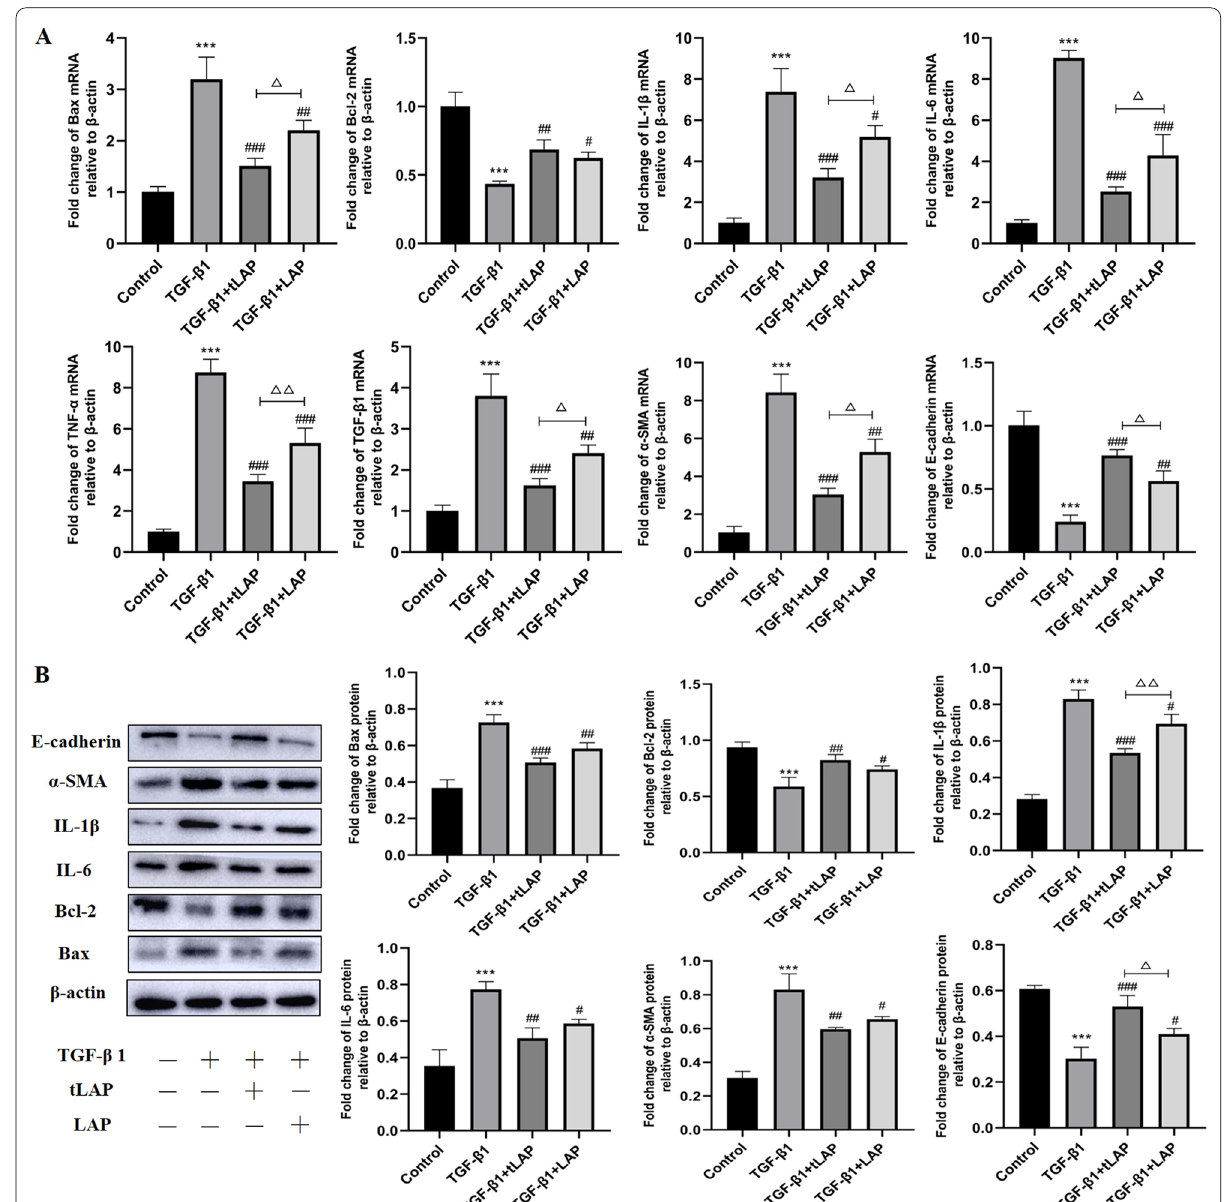
Fig. 3 Detection of the effects of LAP and tLAP on TGF-β1-induced apoptosis and EMT in AML12 cells. A Detection of the mRNA expression of Bax, Bcl-2, IL-6, IL-1β, TNF-α, TGF-β, α-SMA and E-cadherin in AML12 cells. B Detection of the expression of Bax, Bcl-2, IL-6, IL-1β, α-SMA and E-cadherin in AML12 cells. ***P < 0.001 vs control group; # P < 0.05 vs TGF-β1 group; ## P < 0.01 vs TGF-β1 group; ### P < 0.001 vs TGF-β1 group; △ P < 0.05, TGF-β1 tLAP group vs TGF-β1 LAP group; △△ P < 0.01, TGF-β1 tLAP group vs TGF-β1 LAP group; △△△ P < 0.001, TGF-β1 + + + + TGF-β1 LAP group +